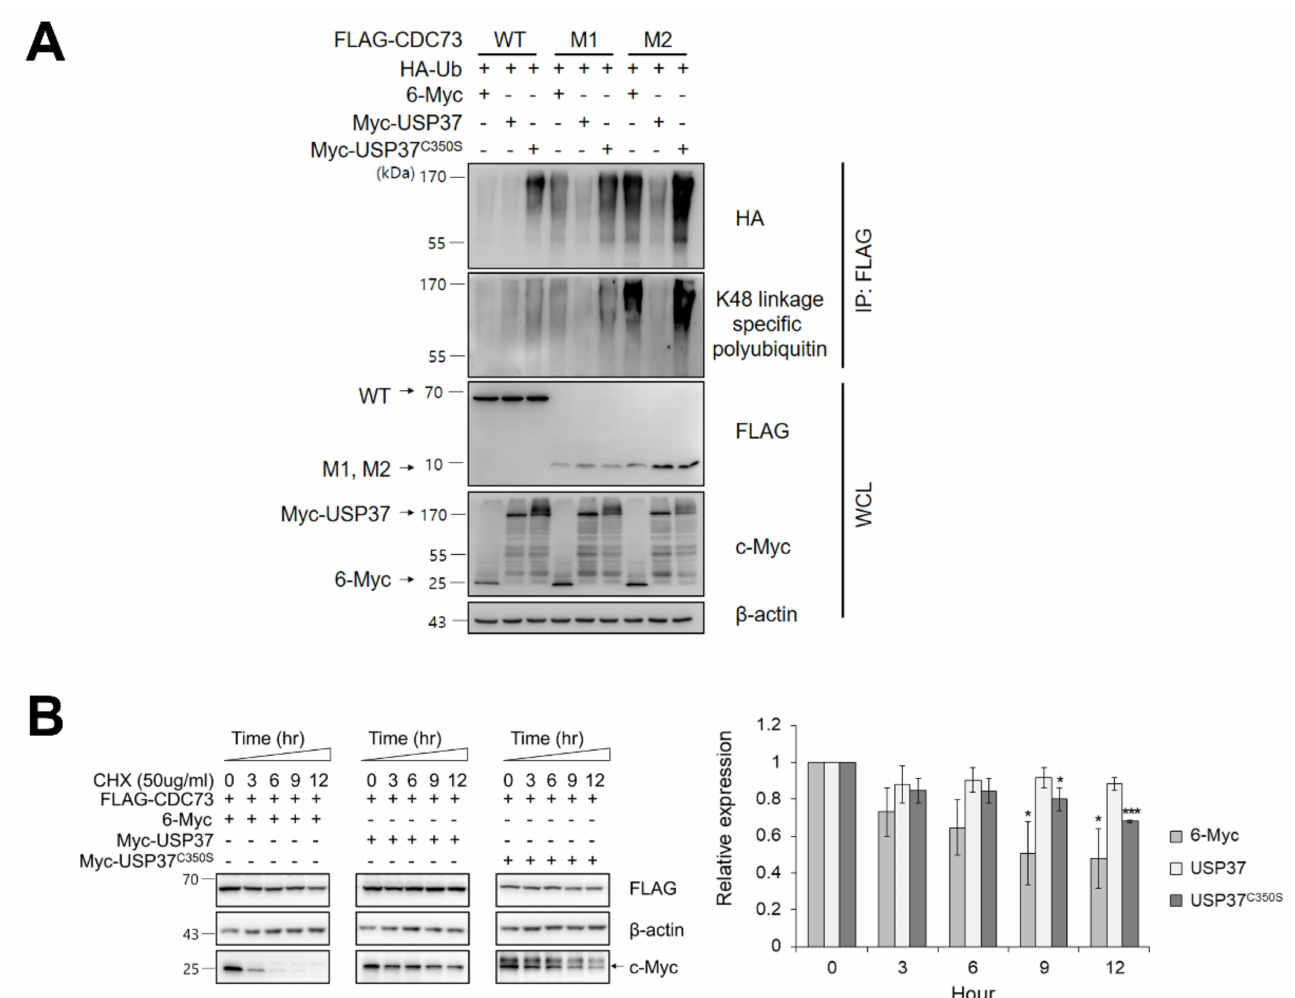
Figure 4. USP37 deubiquitinates and stabilizes CDC73. USP37 deubiquitinates CDC73 ( A ). To examine deubiquitination of CDC73, COS7 cells were transfected with FLAG-(WT, M1, M2) CDC73, HA-ubiquitin, Myc-USP37 or Myc-USP37 C350S and 6-Myc and treated 25 µ M MG132 for 4 h. Cell lysates were immunoprecipitated with anti-FLAG antibody and Western blotting was performed with anti-HA antibody and antibodies specific for K48-linked polyubiquitin. USP37 stabilizes CDC73 ( B ). To examine the stability of CDC73 expression, FLAG-CDC73 co-transfected along with 6-Myc, Myc- USP37 or Myc-USP37 C350S into COS7 cells and the cells were treated with 50 µ g/mL cycloheximide ( n = 3 for each group). * p < 0.05, *** p < 0.001 vs. 0 h. IP, immunoprecipitation; WCL, whole cell lysate; CHX,